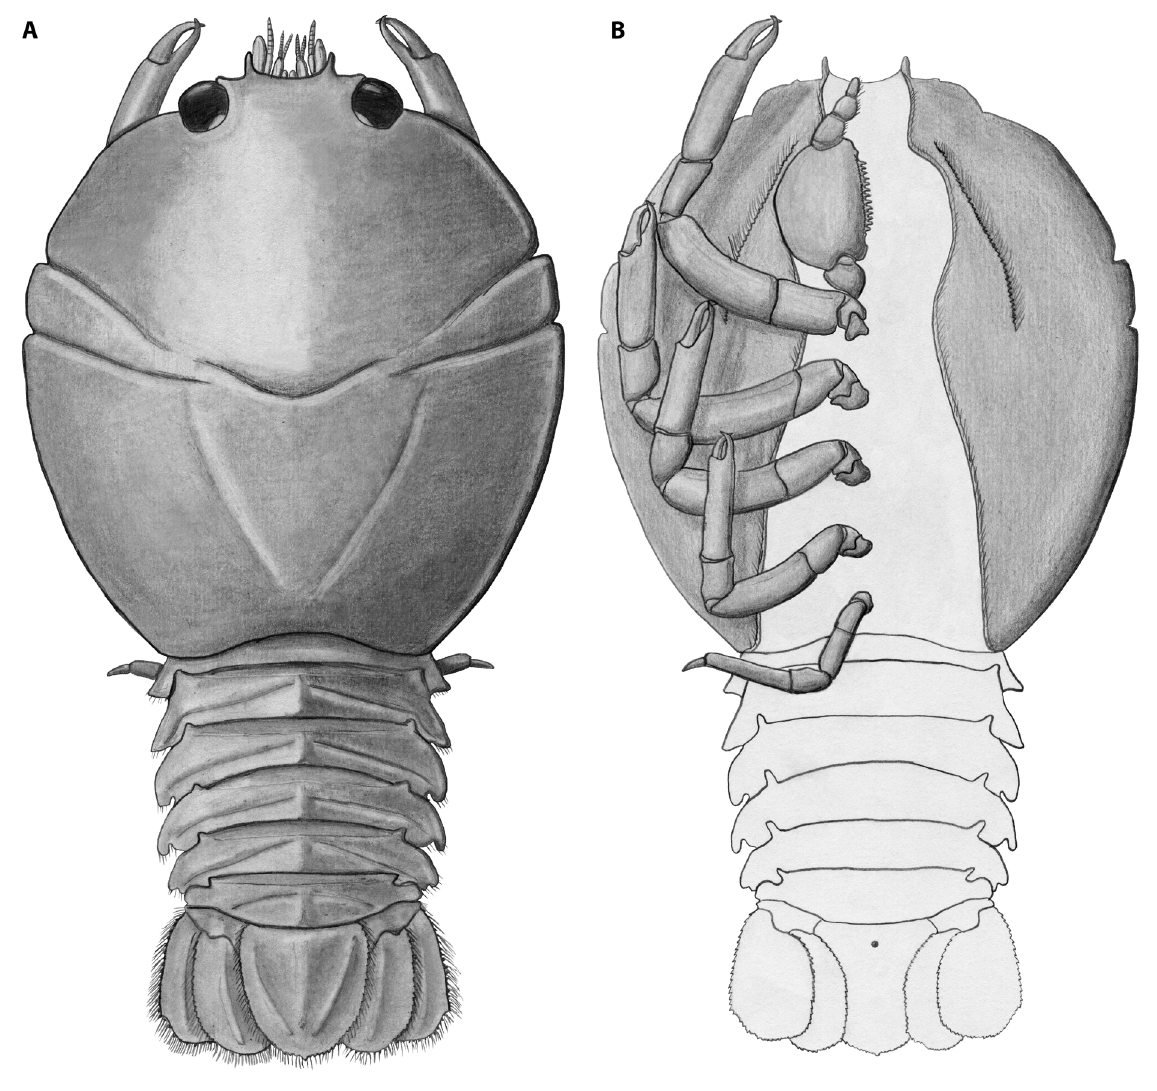
Fig. 6. Reconstruction of Rogeryon oppeli (Woodward, 1866). A . Dorsal aspect. B . Known parts of the ventral aspect, thoracic appendages omitted on the right side. Please note that due to the softness of the carapace, its precise outline is uncertain. Image hand-drawn by D.